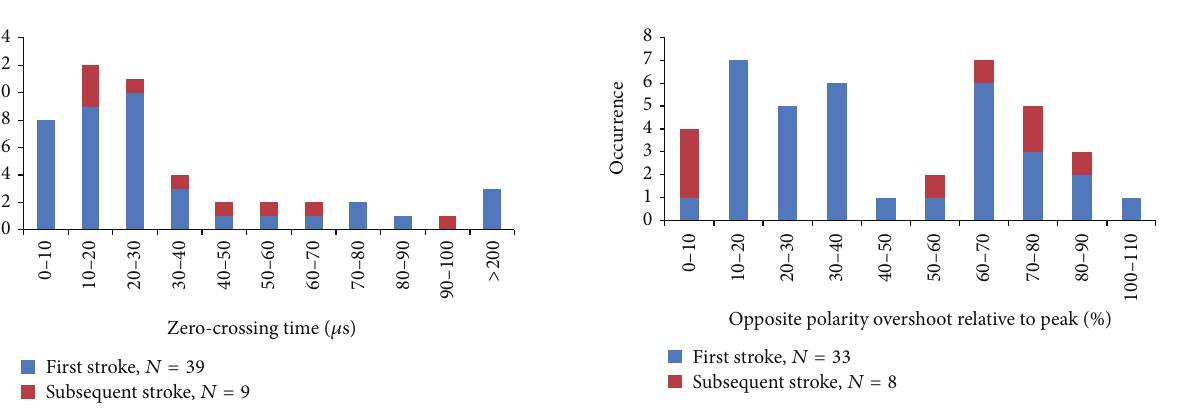
Figure 10: Histograms of zero-crossing time for 48 positive return strokes.